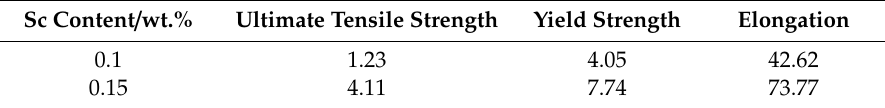
Table 6. The improvement rate of mechanical properties by adding Sc element. (%).